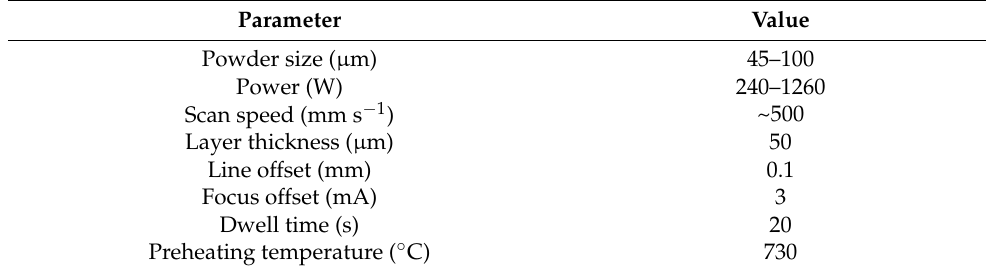
Table 1. Building parameters used for sample preparation.